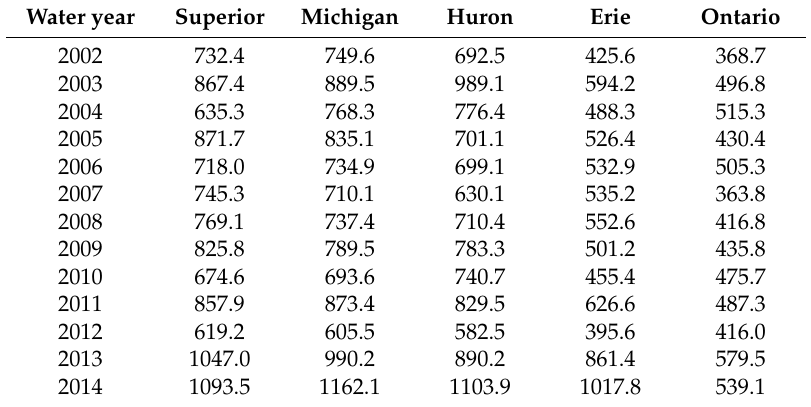
Table 7. Over-lake monthly average cumulative evaporation (mm) based on the water